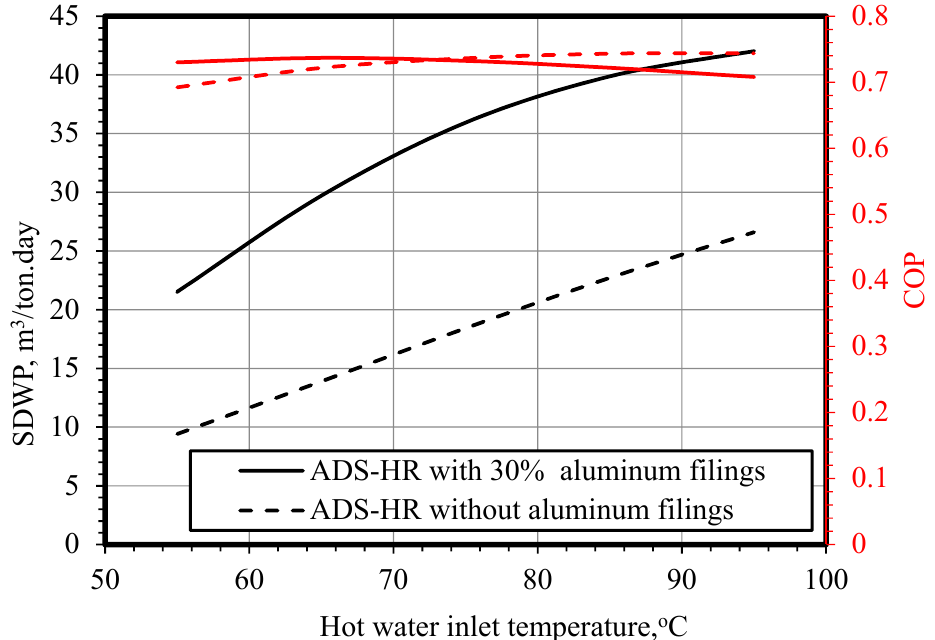
Figure 4. SDWP and COP at different driving temperatures with and without aluminum filings employing heat recovery.